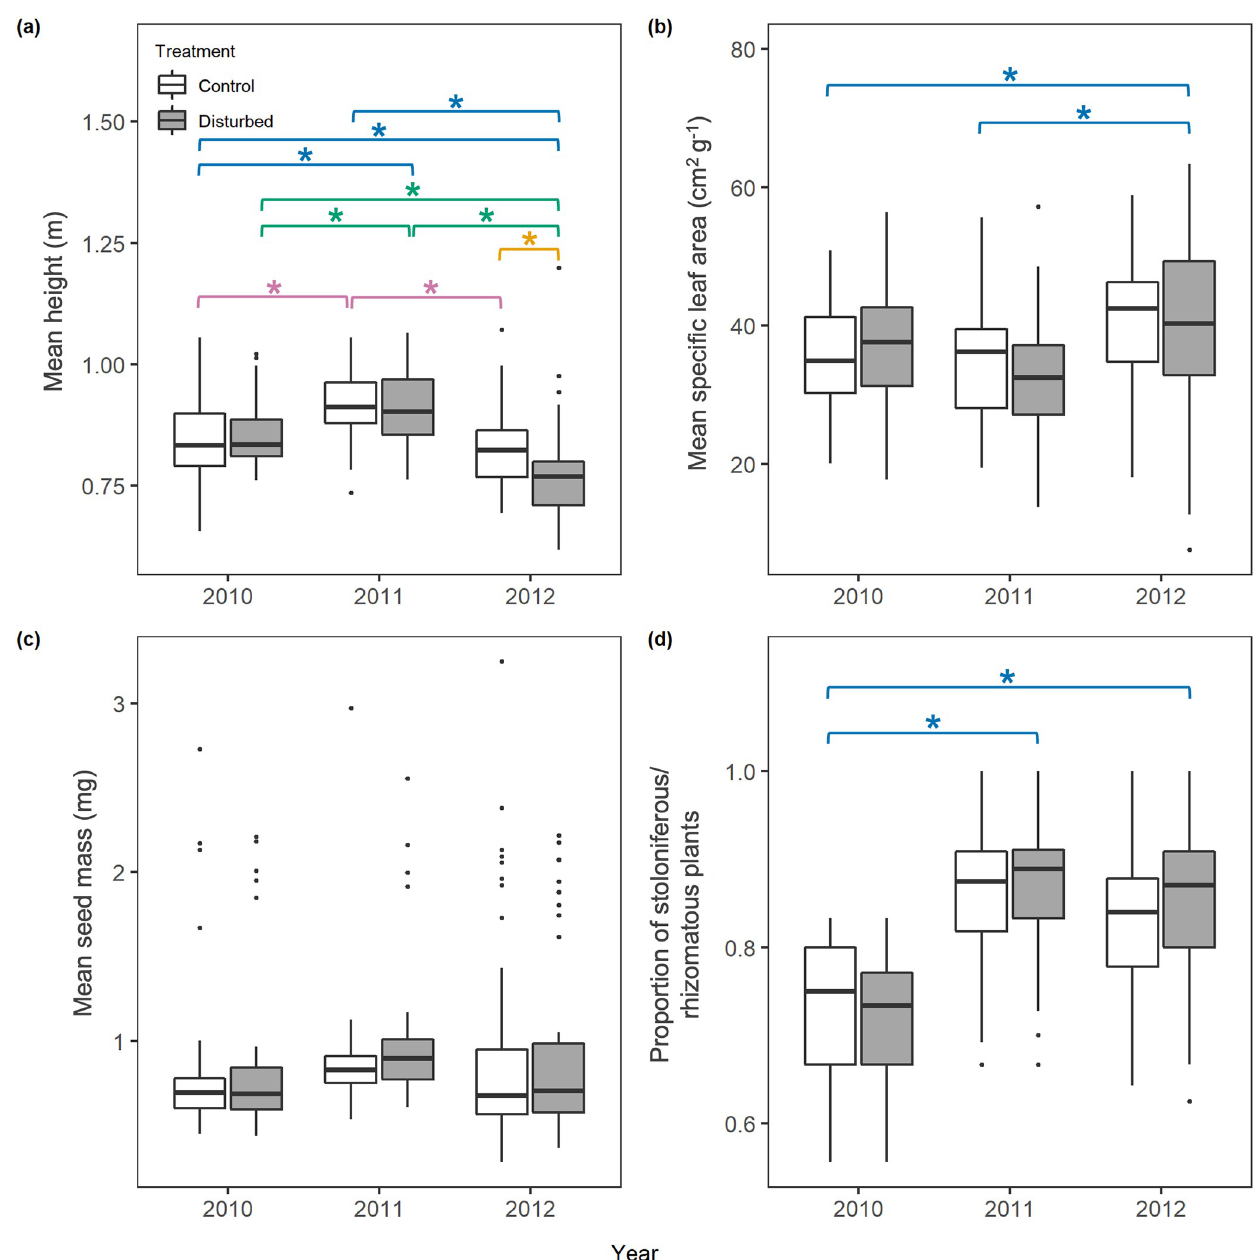
Fig 3. Mean height (cm), mean specific leaf area (SLA; cm 2 g -1 ), mean seed mass (g), and proportion of stoloniferous species boxplots. Boxplots illustrating mean height (cm; A), mean SLA (cm 2 g -1 ; B), mean seed mass (g; C), and the proportion of stoloniferous species (D) between control and disturbed treatments and across years (2010–2012). Boxes represent the 25 th to 75 th percentiles of the data, and whiskers represent the 10 th and 90 th percentiles. Points above and below the box represent the 5 th and 95 th percentile outliers. Blue significance bars marked with an asterisk indicate significant differences among years. Green significance bars marked with an asterisk indicate significant differences within the disturbed treatment among years. Pink significance bars marked with an asterisk indicate significant differences within the control treatment among years. Orange significance bars indicate significant differences between the control and disturbed treatments within a year. Mean height varied across all three years; mean height was 8% higher in 2011 than in 2012. In 2012, mean height was 5.1% lower than in 2010 and 12.1% lower than in 2011. Treatments only varied in mean height in 2012. In that year, mean height in disturbed plots was 6.4% lower. Mean SLA increased in 2012 compared to the previous two years; from 2010 to 2012, mean SLA increased by 11.4%, and from 2011 to 2012 it increased by 18.9%. Mean seed mass did not differ between treatments or years. The proportion of stoloniferous/rhizomatous species increased from 2010 to 2011 by 19.3% and from 2010 to 2012 by 14.8%, but did not differ between 2011 and 2012.